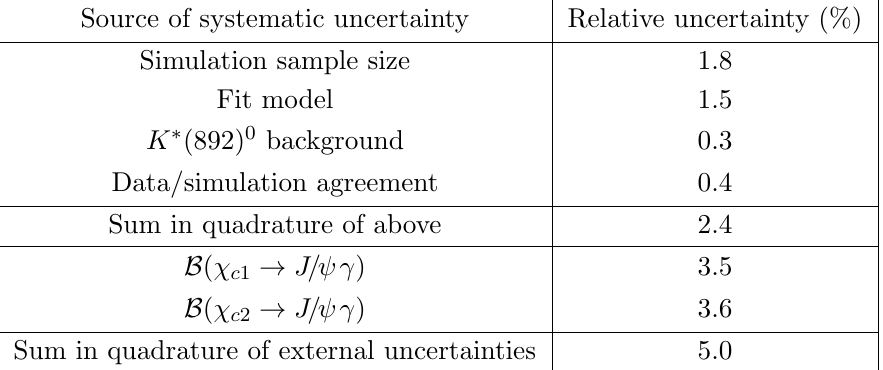
Table 2 . Systematic uncertainties for the measurement of the ratio B ( B 0 (cid:31) c 1 K + K (cid:0) ).